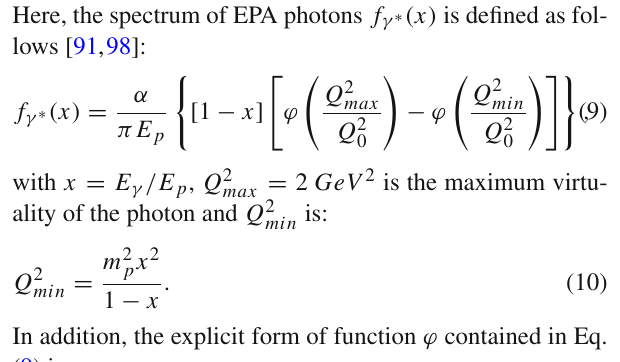
4 The total cross-section for one exchanged quasi-real